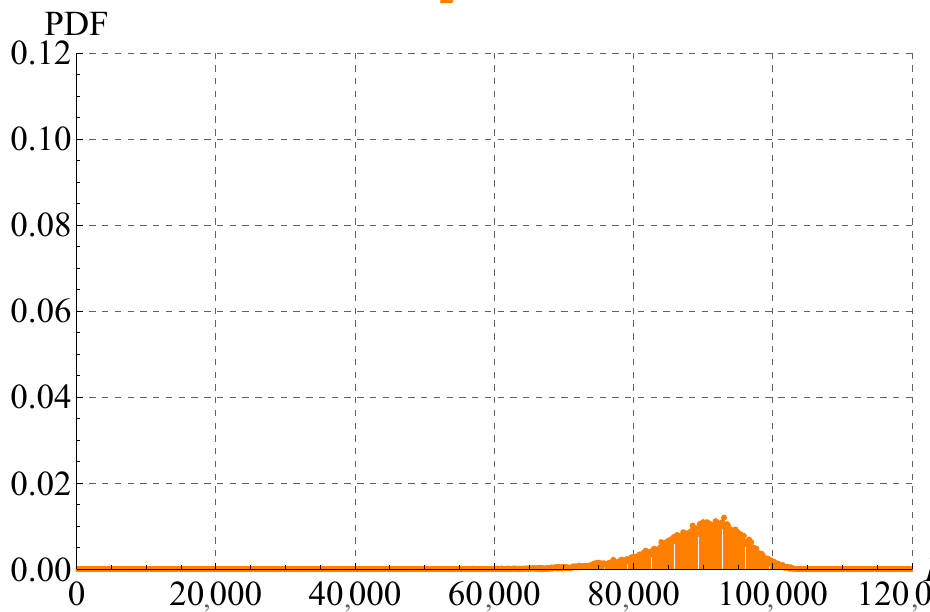
Figure 11. Probability density function (PDF), solution of Equation (36). Screenshoot at time ˆ t =